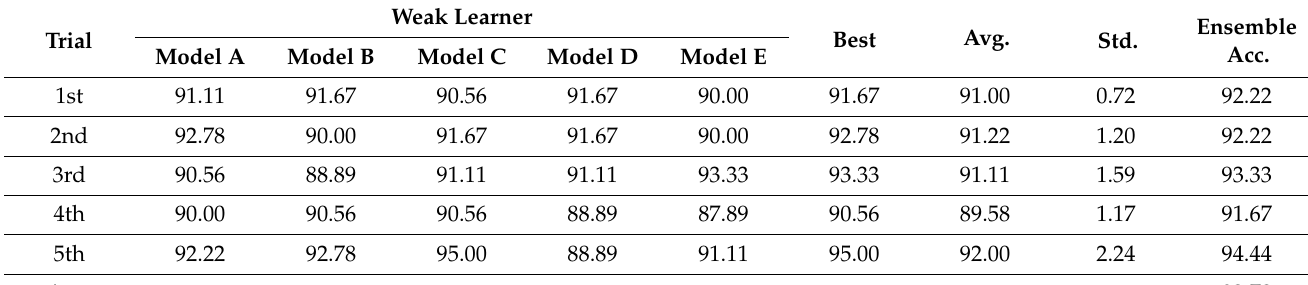
Table 5. Results of five ensemble models.